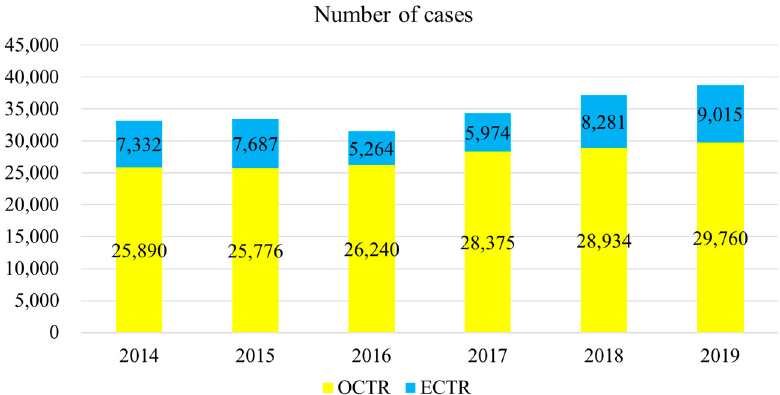
Figure 1. Trends in surgical techniques, 2014–2019 (6 years). OCTR; open carpal tunnel release, ECTR; endoscopic carpal tunnel release.